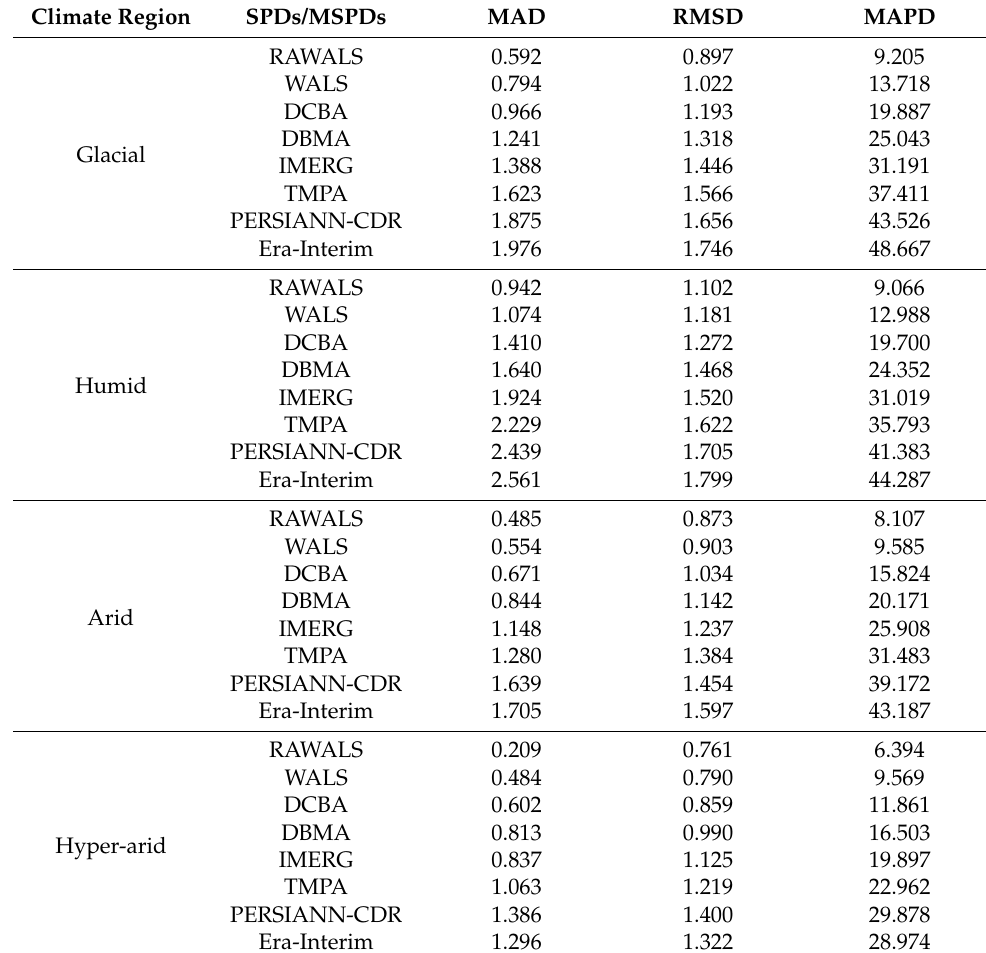
Table 5. Performance assessment of SPDs/MSPDs on a regional scale using SPI-3 estimated from RGs as a